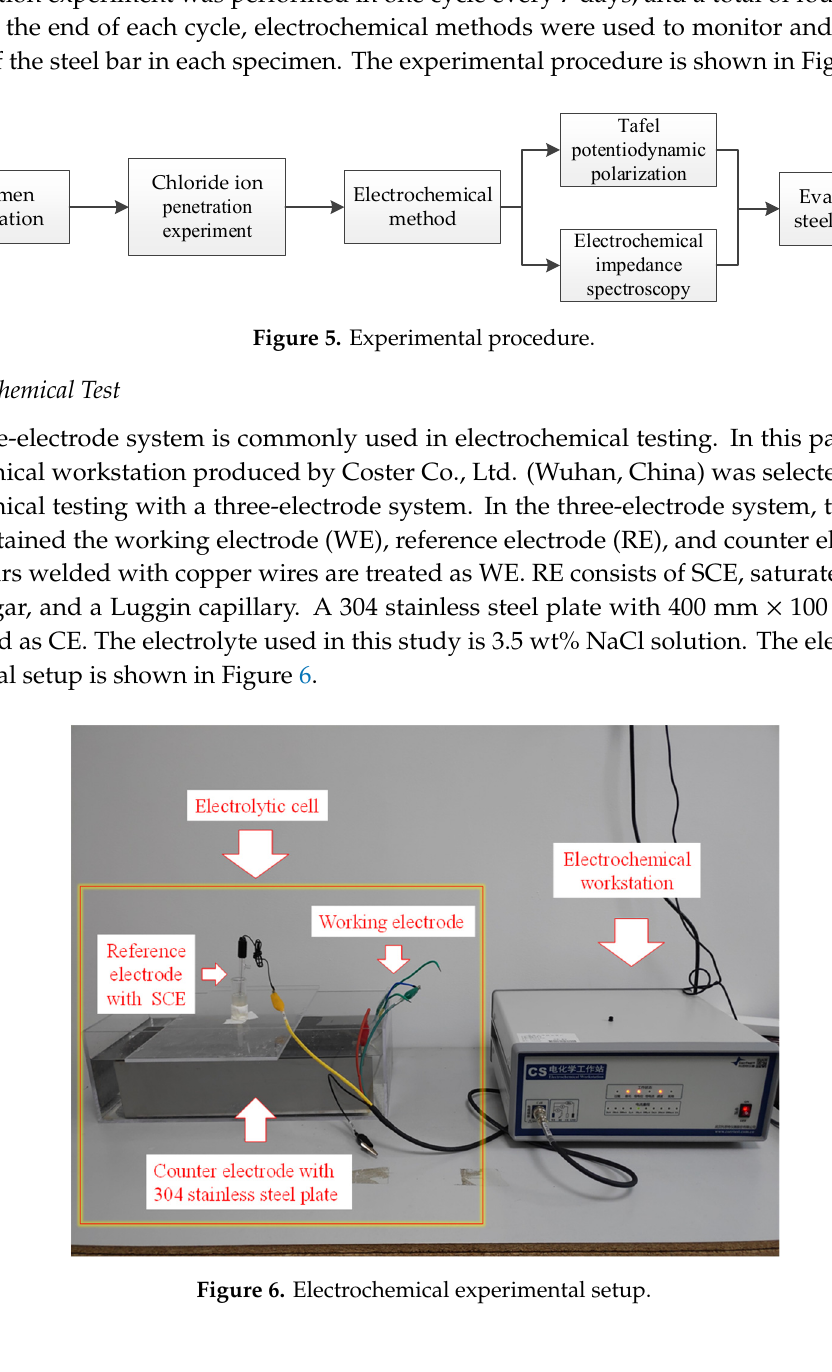
Figure 7. Tafel curves of all specimens (chloride ion penetration time: 7d). Generally, when the E corr was less than − 0.275 V vs. SCE, there was a greater than 90% probability that steel bars in concrete structures were corroding [39]. Qualitatively, TPP curve moving in the negative direction of the Y-axis indicates that the corrosion resistance of the steel bar becomes poor. As can be seen from Figure 7, compared with the BFRPC and RPC specimens, the E corr of the BFRPC- C, BFRPC-C-SCID, RPC-C and RPC-C-SCID specimens move in a negative direction of the Y-axis and the E corr value is significantly less than − 0.275 V, which indicates that the cracks weaken the corrosion resistance of the steel bars embedded in BFRPC-C, BFRPC-C-SCID, RPC-C, and RPC-C-SCID.